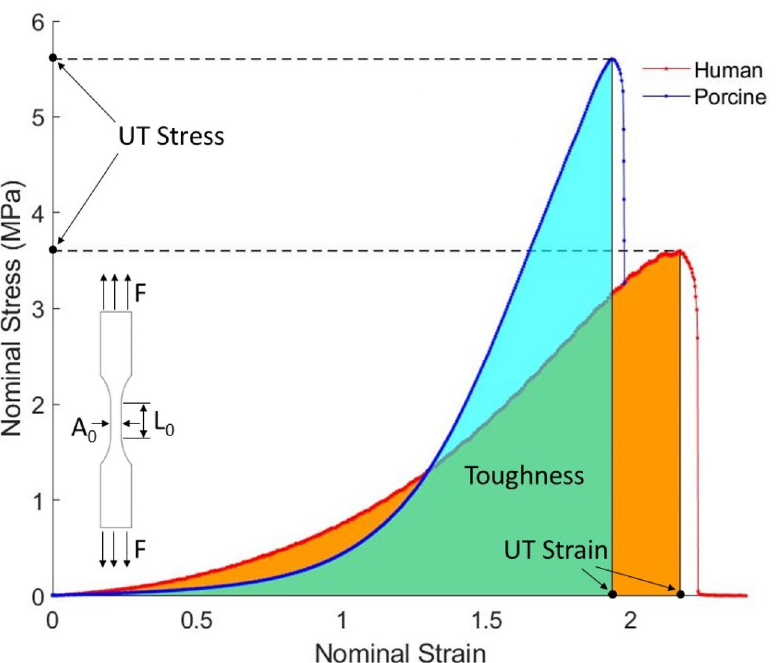
Figure 1. A typical nominal stress–strain curve of the dog bone skin tissue samples under the uniaxial tensile test. The applied force (F), the initial cross-section area (A 0 ), and the initial length (L 0 ) of the sample are shown on the dog-bone